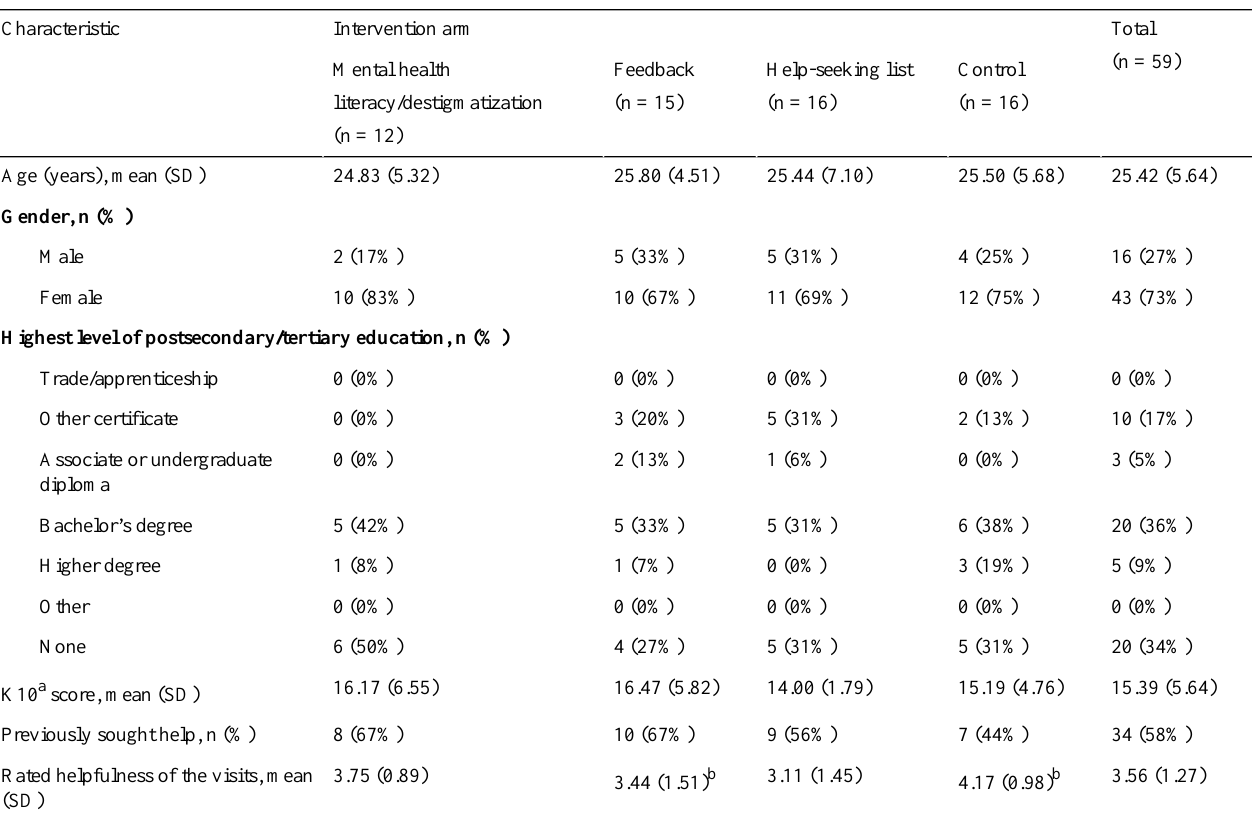
Table 1. Characteristics of participants included in the